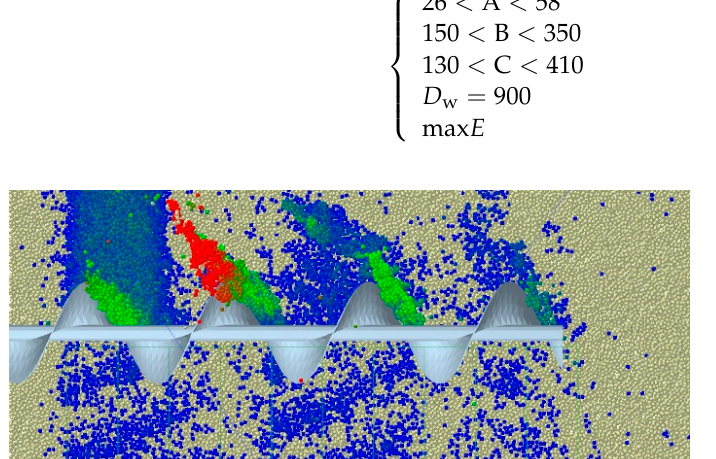
Figure 15. Simulation results after optimizing parameters of spiral soil separating device.